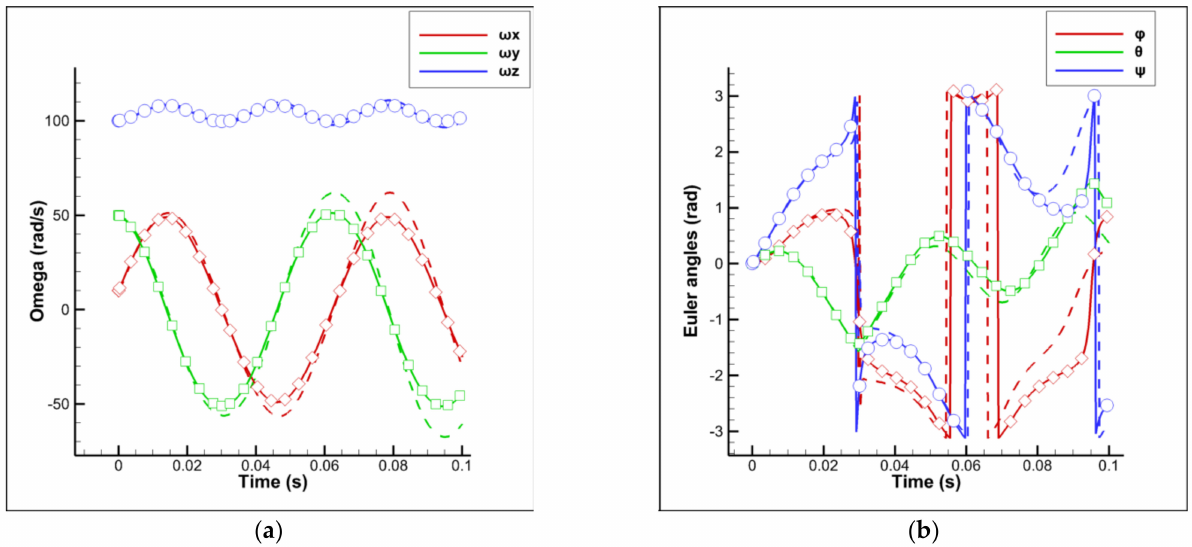
Figure 9. Validation of the 6-DoF solver: ( a ) angular velocities, ( b ) Euler angles. Points are SIMULINK, dashed lines is the present solver without sub-cycling and continuous lines with sub-cycling.